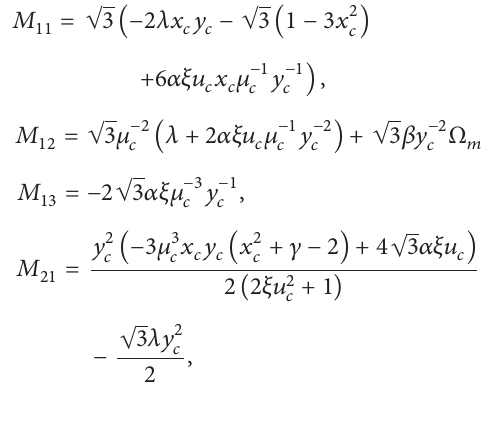
[88]. Moreover, in order to show that there are no significant equilibrium points lost at infinity one can use the Poincare central projection method to investigate the dynamics at infinity [118]. Such method has been applied for teleparallel dark energy model in